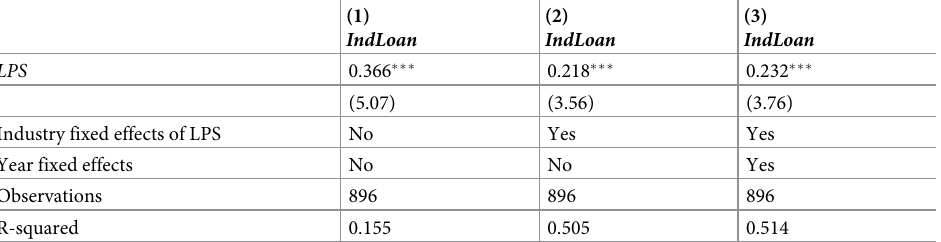
Table 7. The largest private shareholder and bank loans: Alternative sample. This table reports the estimation results from OLS regressions analyzing the impact of the largest private shareholder on bank lending to their industry, with a different combination of fixed effects in each column. Columns 1–3 uses IndLoan as the dependent variable. Variables are defined in S1 Appendix. The top three industry in each region with a share of the overall economy has been removed. The sample period is from 2007 to 2020. In parentheses are t-statistics. ��� , �� , � indicate statistical sig- nificance at the 1%, 5%, and 10% level, respectively.